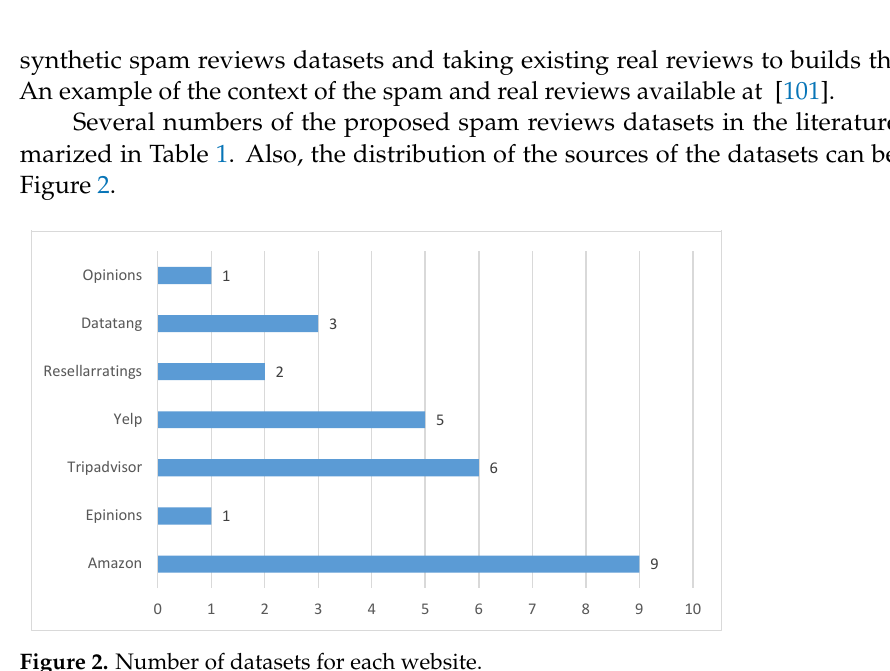
Figure 2. Number of datasets for each website. Table 1. Descriptions of spam reviews datasets in